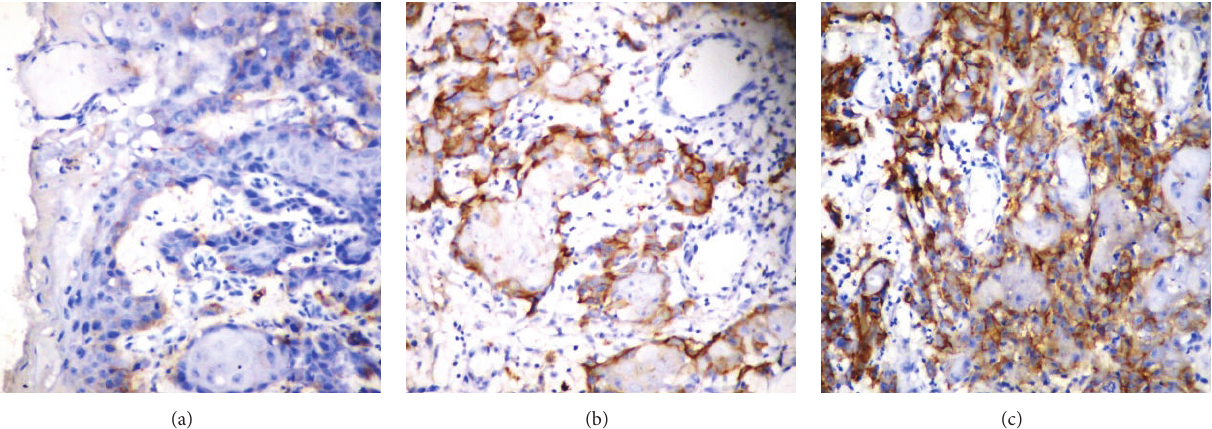
Figure4: (a) Expressionofpodoplanin in OSCC:weak reactivity ( > 10%tumorcells positiveand weak staining). (b)Expressionofpodoplanin in OSCC: moderate reactivity (10–30% tumor cells positive and moderate staining). (c) Expression of podoplanin in OSCC: high reactivity (50–80% tumor cells positive and strong